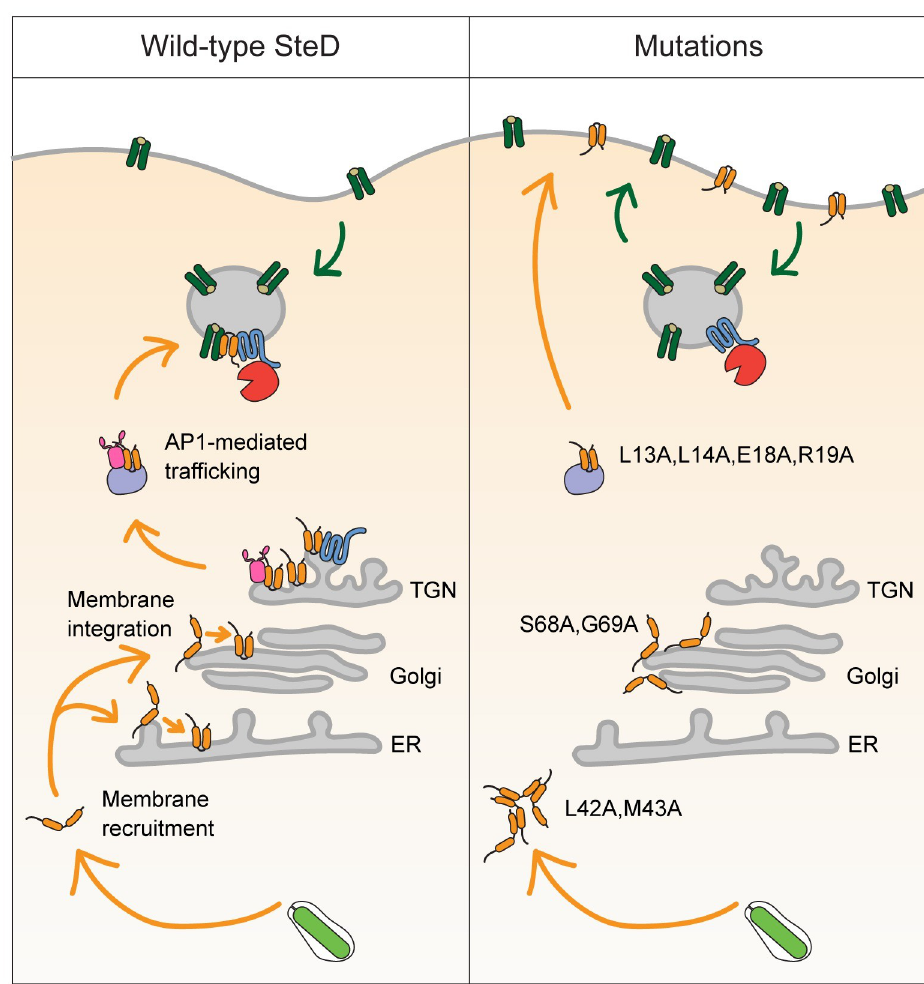
Fig 8. Model of SteD membrane integration and localisation. Following translocation from Salmonella (green) into the cytoplasm SteD (orange) is recruited to the membranes of the early secretory pathway where it integrates. SteD then migrates to and accumulates within the TGN. Through interaction with the AP1 complex (pink) it is trafficked to MHCII compartments, where it interacts with mMHCII (dark green), which is ubiquitinated through the actions of TMEM127 (blue) and WWP2 (red) causing a reduction in mMHCII surface levels. SteD L42A,M43A mutation prevents membrane recruitment leading to aggregation in the cytoplasm. SteD S68A,G69A mutation prevents membrane integration resulting in a Golgi-associated non-integrative state. SteD L13A,L14A,E18A,R19A mutation prevents AP1 interaction leading to mis-trafficking of SteD to the plasma membrane.